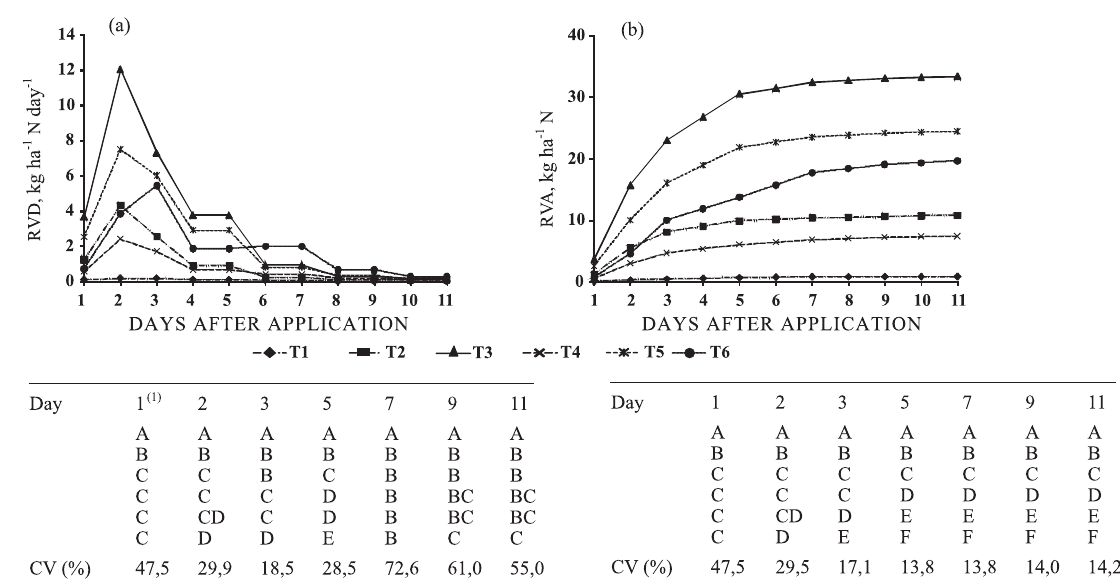
Figure 4. N-NH Daily Volatilization Rate (DVR) (a) and N-NH 3 based on the treatments applied in the second side-dressing fertilization, 52 days after corn